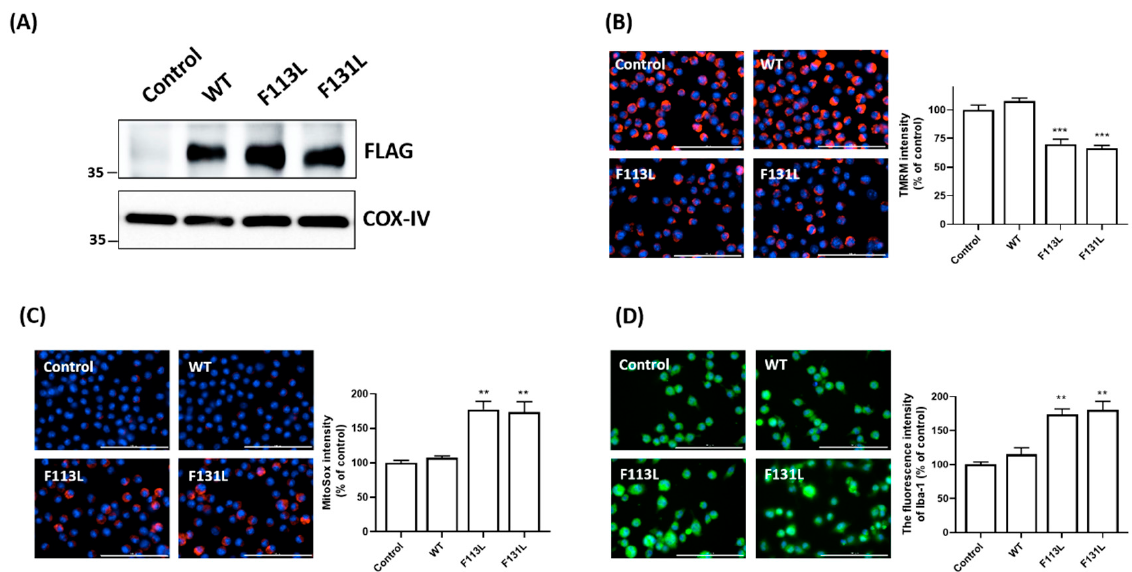
Figure 1. Mutant (F113L) or (F131L) TOMM40 causes dysfunction and oxidative stress of mitochondria, leading to microglial activation. ( A ) BV2 microglial cells were transfected with empty pcDNA3 vector (control), cDNA of FLAG-tagged wild-type (WT), (F113L), or (F131L) TOMM40. Immunoblotting assay showed that WT or mutant TOMM40 was expressed in the mitochondrial fraction of BV2 microglial cells. Cytochrome c oxidase subunit IV (COX-IV) was used as an internal control for mitochondrial fraction. ( B ) Compared to control cells or cells expressing WT TOMM40, decreased TMRM fluorescence intensity and depolarization of mitochondrial membrane potential were BV2 microglial cells expressing mutant (F113L) or (F131L) TOMM40. ( C ) Expression of mutant (F113L) or (F131L) TOMM40 significantly increased fluorescence intensity of MitoSox and mitochondrial superoxide level in BV2 microglial cells. ( D ) Immunofluorescence staining of microglial marker Iba-1demonstrated that expression of (F113L) or (F131L) TOMM40 led to activation of BV2 microglial cells by upregulating protein expression of Iba-1. Scale bar is 100 µ m. Each bar represents mean ± S.D. value of four experiments. Each experiment was performed in triplicate. ** p < 0.01, *** p < 0.001 compared to control BV2 microglial